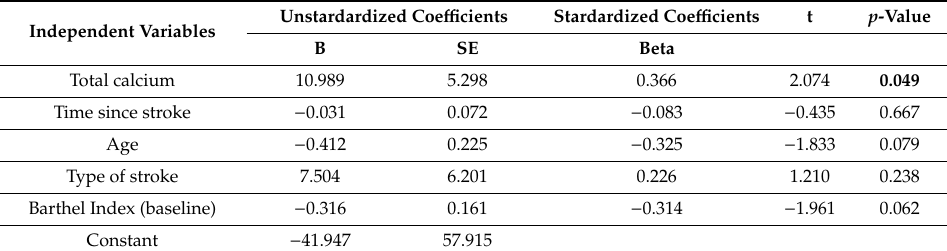
Table 3. Multiple regression